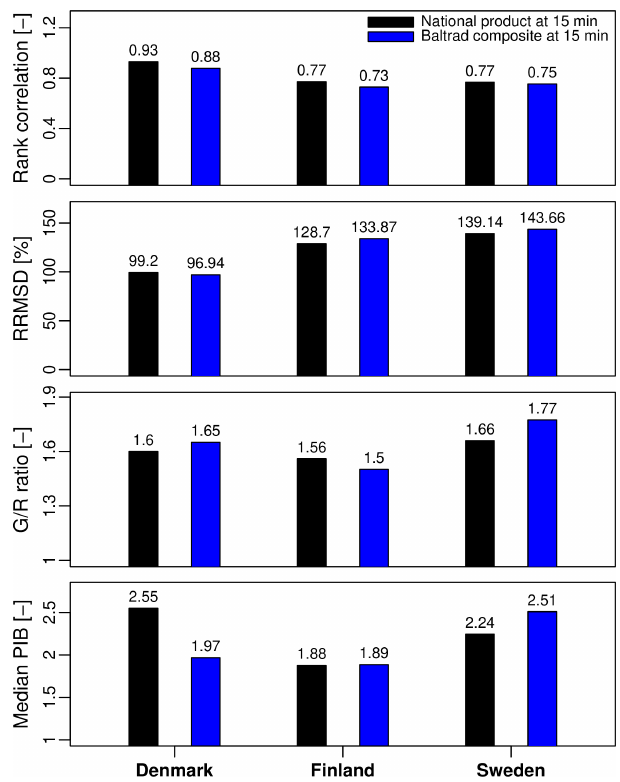
Figure 13. Rank correlation, relative root mean square difference, G / R ratio and peak intensity bias (at 15min resolution) of the na- tional radar products and the BALTRAD